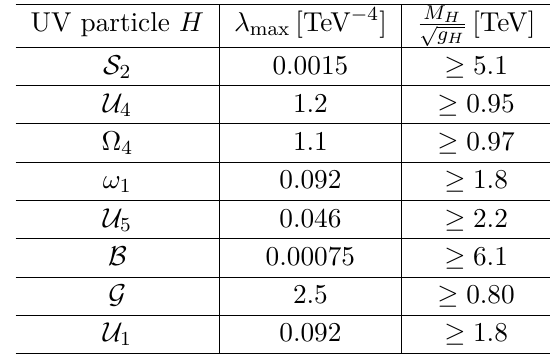
√ g H assuming C 4 = 0 ± 10 , C 5 = 0 ± 10 . This is for